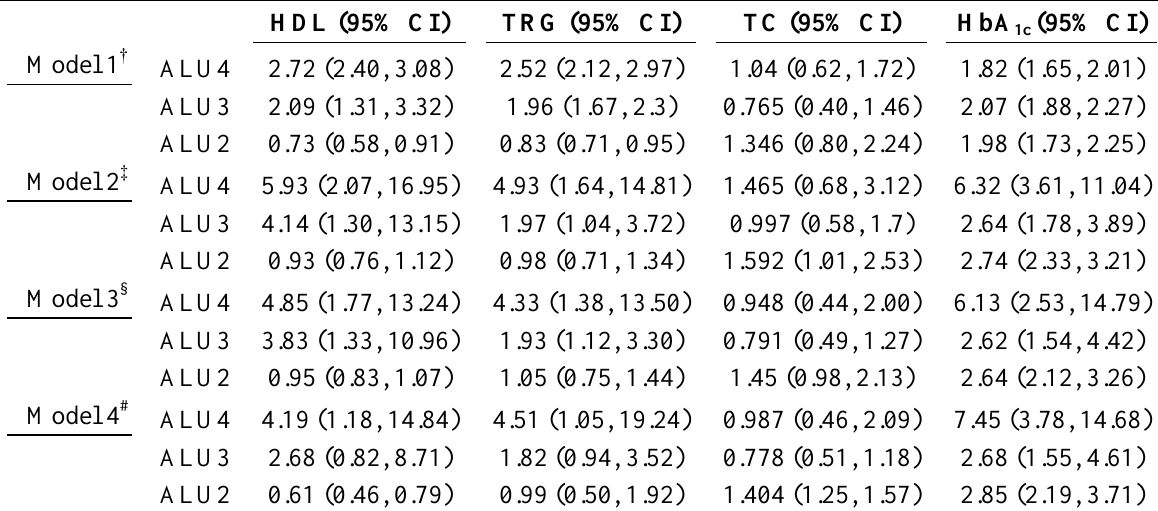
Table 3. Odds Ratios for Total Cardiometabolic Risk Score Sub-Component Analysis. *